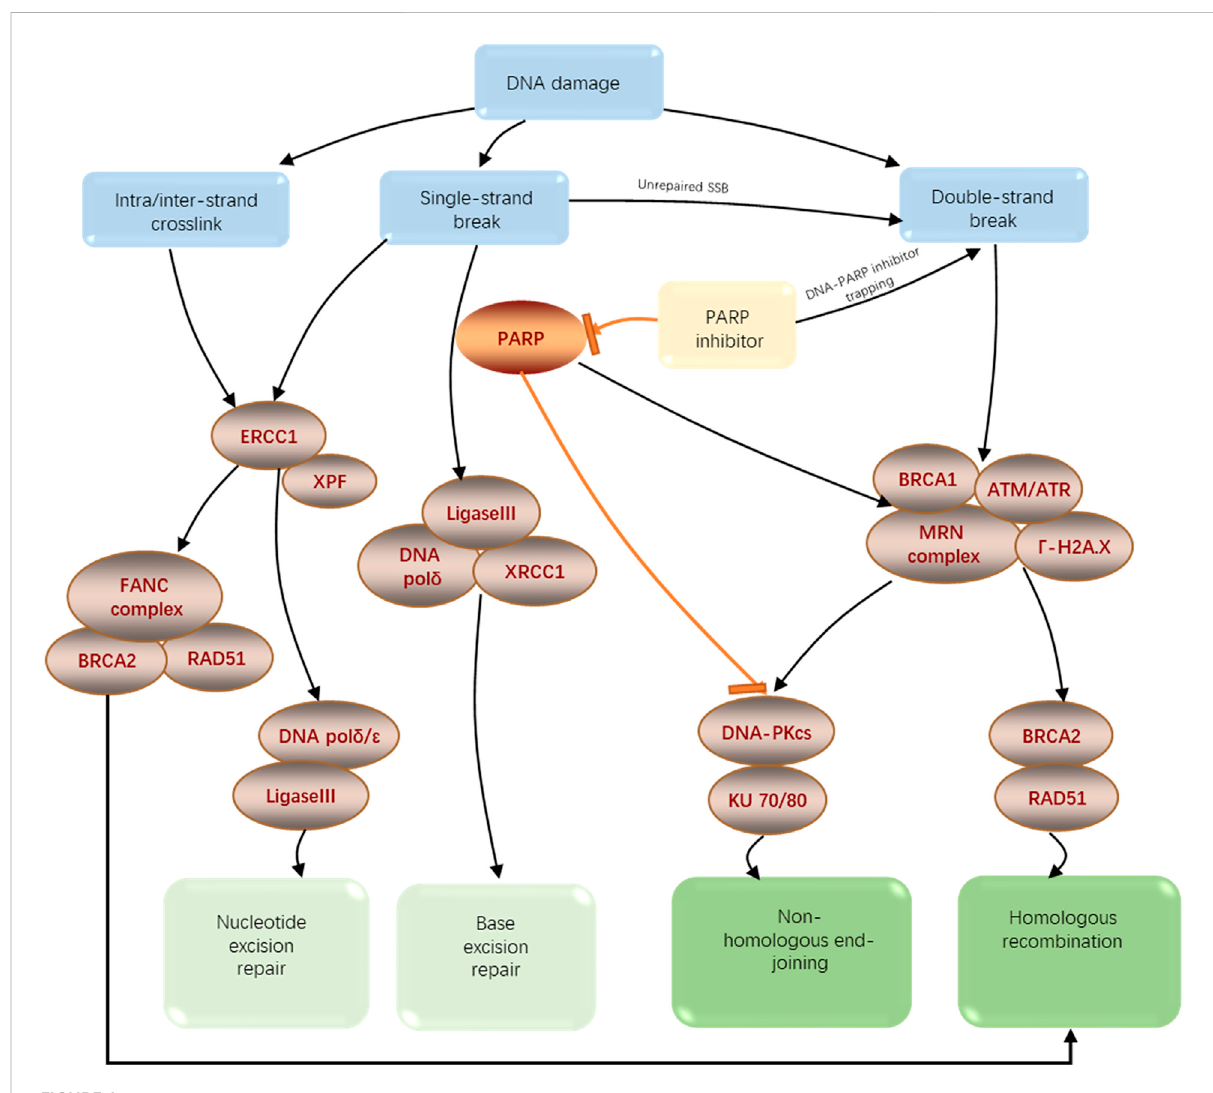
FIGURE 1 Schematic diagram of the DNA damage repair